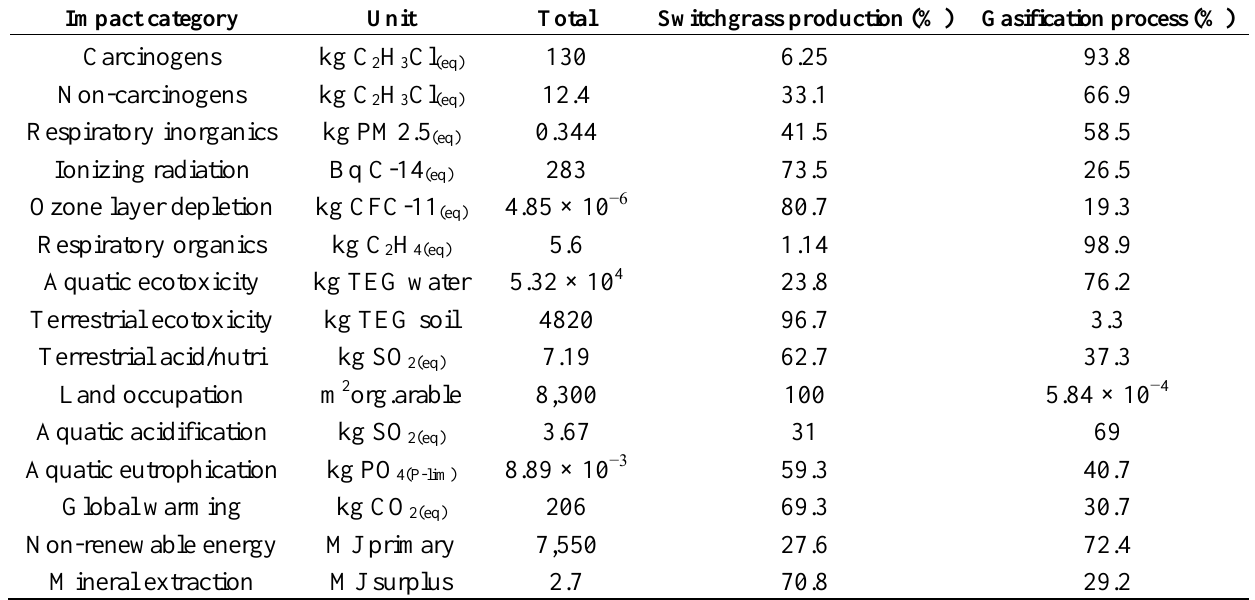
Table 4. Characterization LCIA results of biochar production. Functional unit = 952